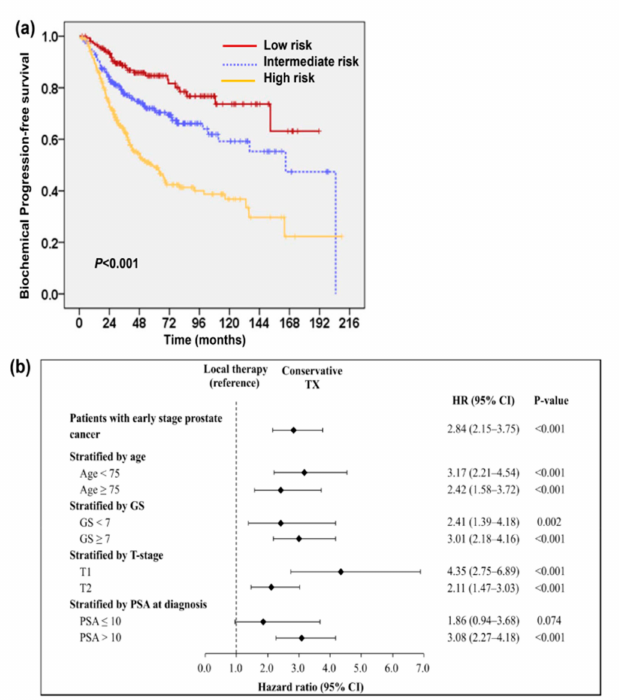
Figure 2. Factors correlated with clinical outcome of patients with localized prostate cancer. Kaplan- Meier PFS survival curves of 687 patients stratified by risk groups ( a ). Additional, local therapy significantly improved PFS when patients were stratified by clinical risk factors ( b